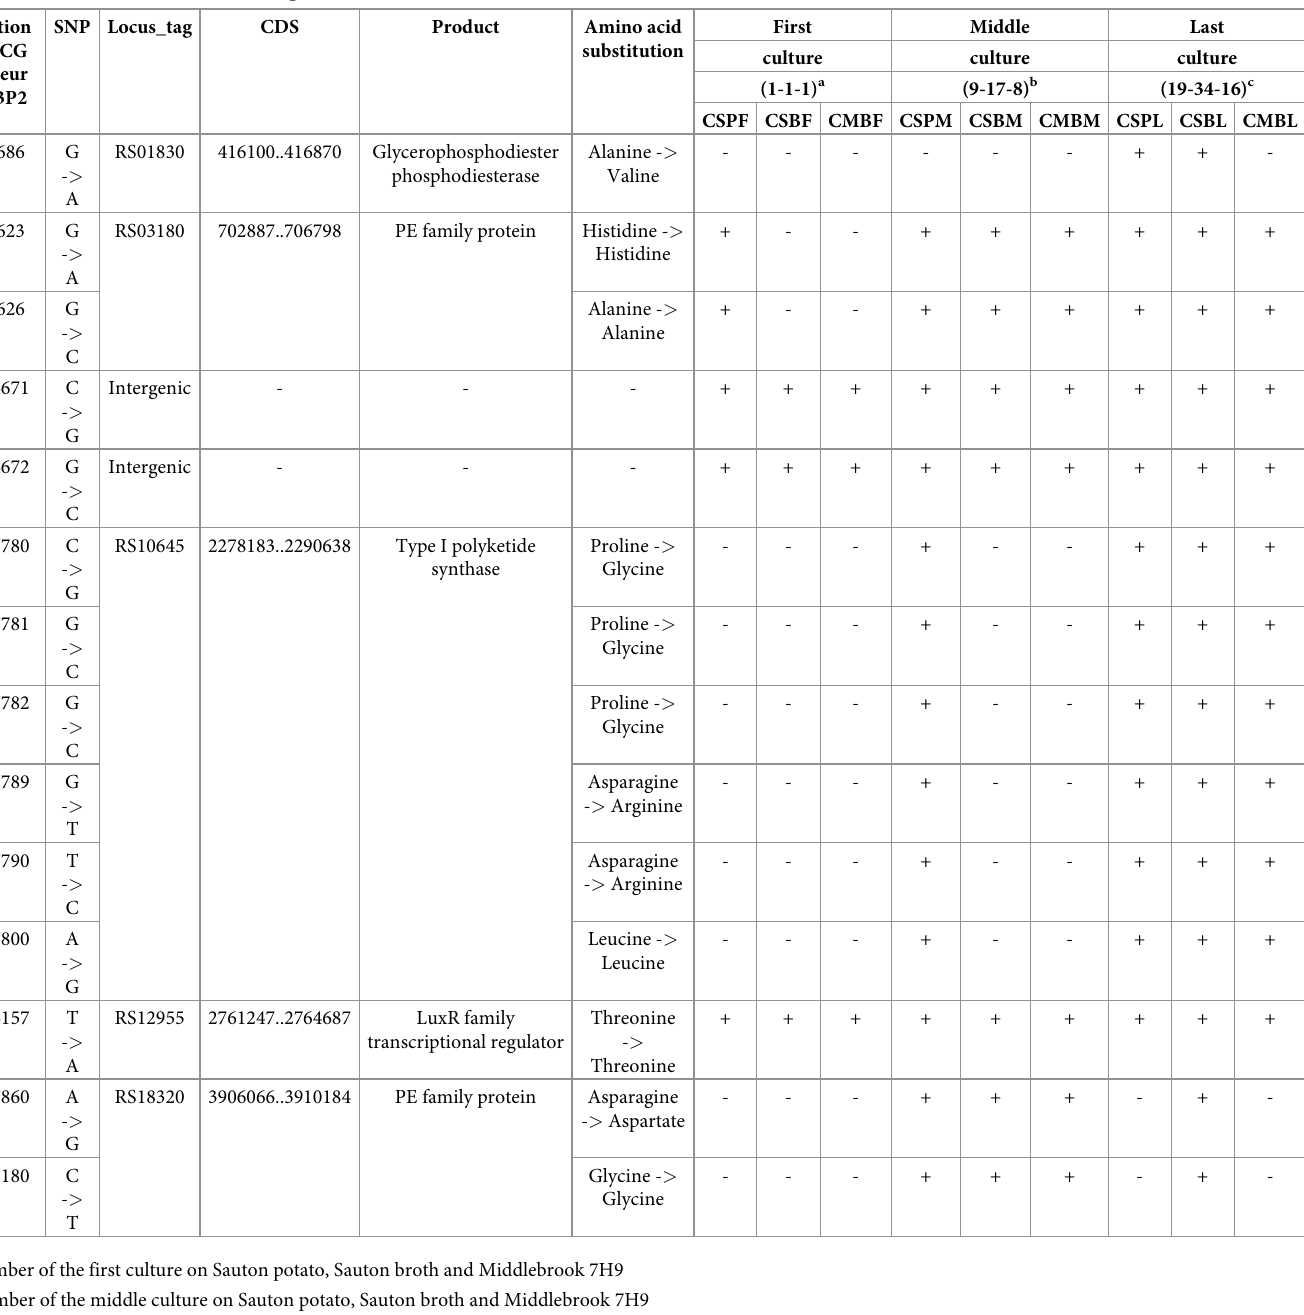
Table 3. List of SNPs in the selected samples from the seed